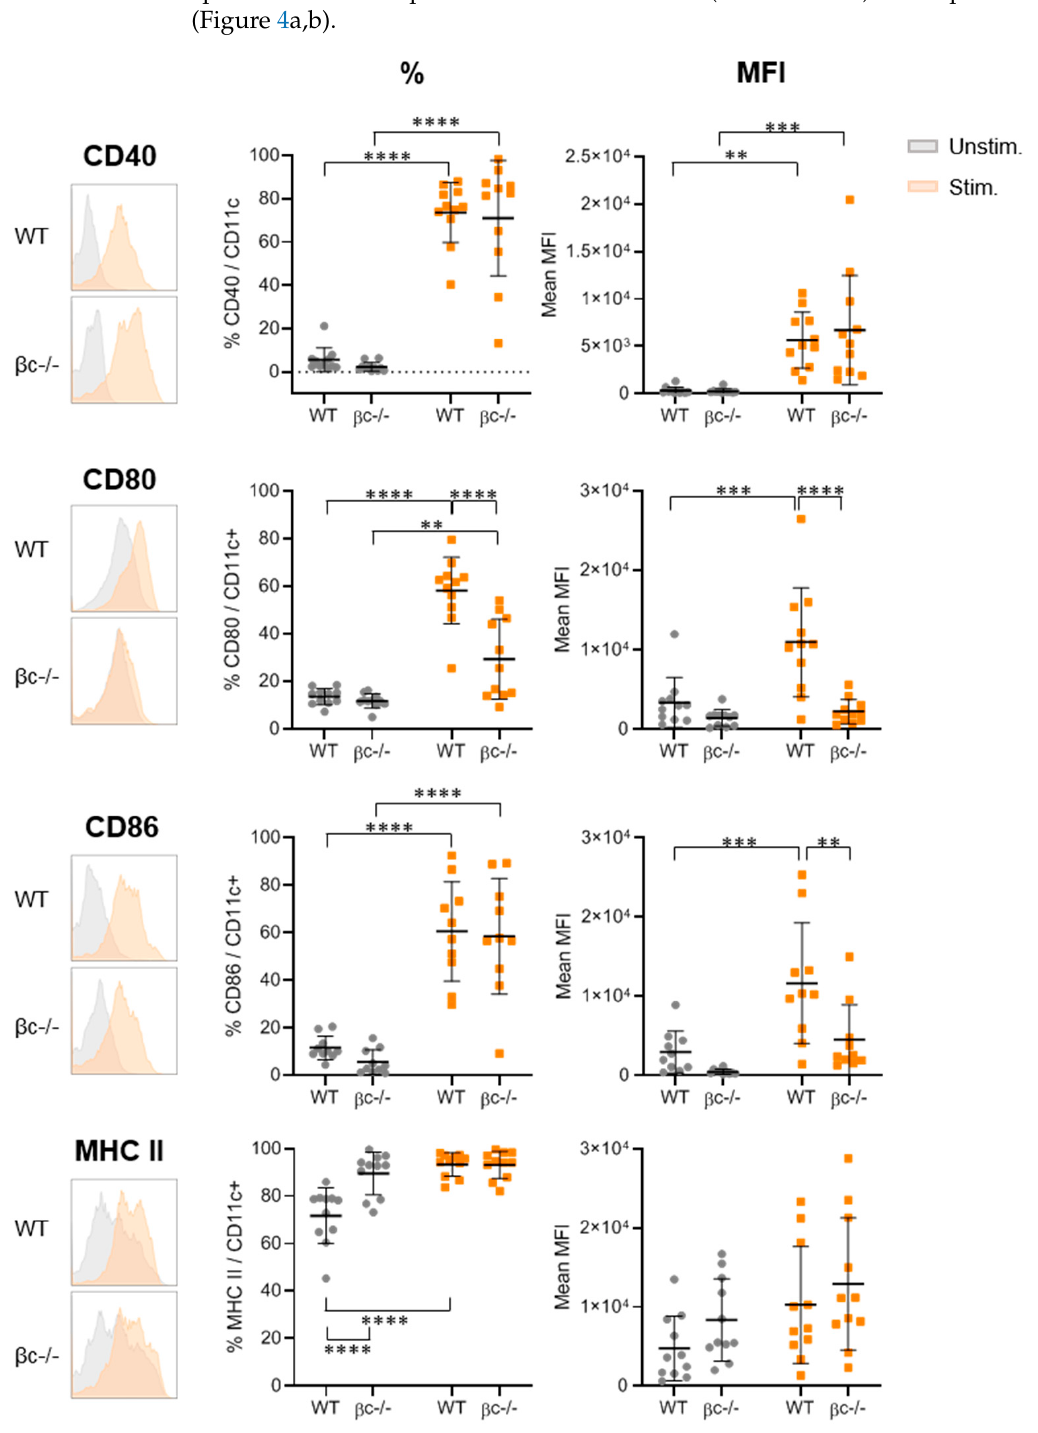
Figure 2. The maturation profile of DC β c-/- is different from that of DC WT . DC generated from WT or β c-/- BalbC mice were stimulated with LPS during two days. Co-stimulatory (CD40, CD80 and CD86) and MCH II expression is evaluated by flow cytometry. Histograms are representative from one out of eleven different experiments. Scatter dot plots are the cumulative results of the percentage of positive cells among CD11c+ cells and the mean of MFI for each markers. Differences regarded as statistically significant between the groups are presented as follows: * p < 0.05, ** p < 0.01, *** p < 0.001 and **** p < 0.0001.